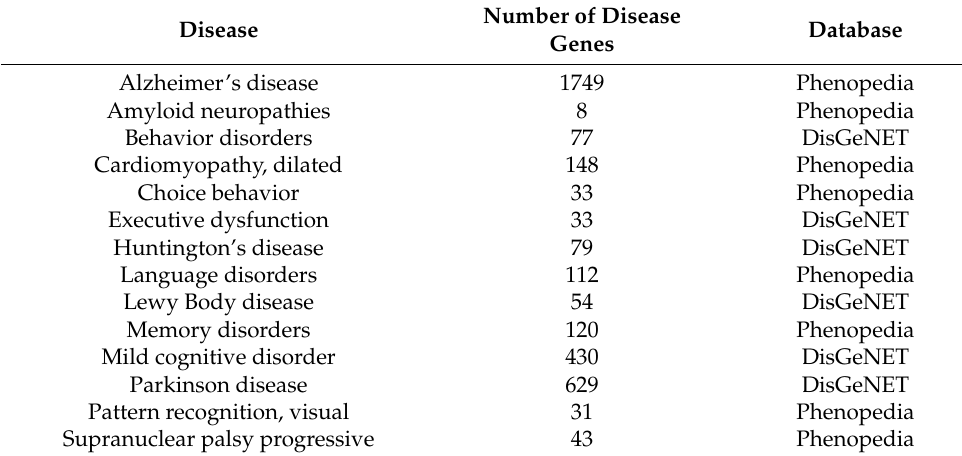
Supranuclear palsy progressive